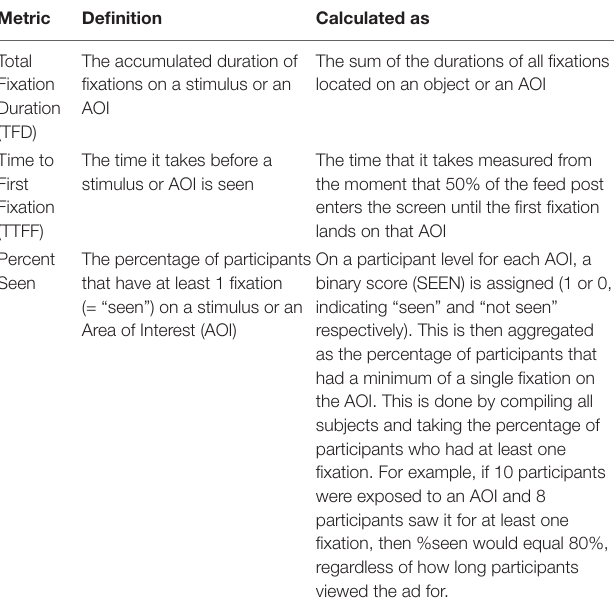
TABLE 6 | The definition and calculation of the metrics of